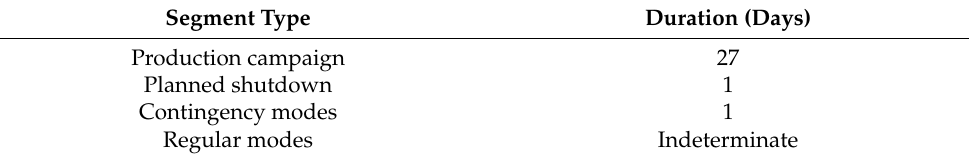
Table 6. Summary of time segment